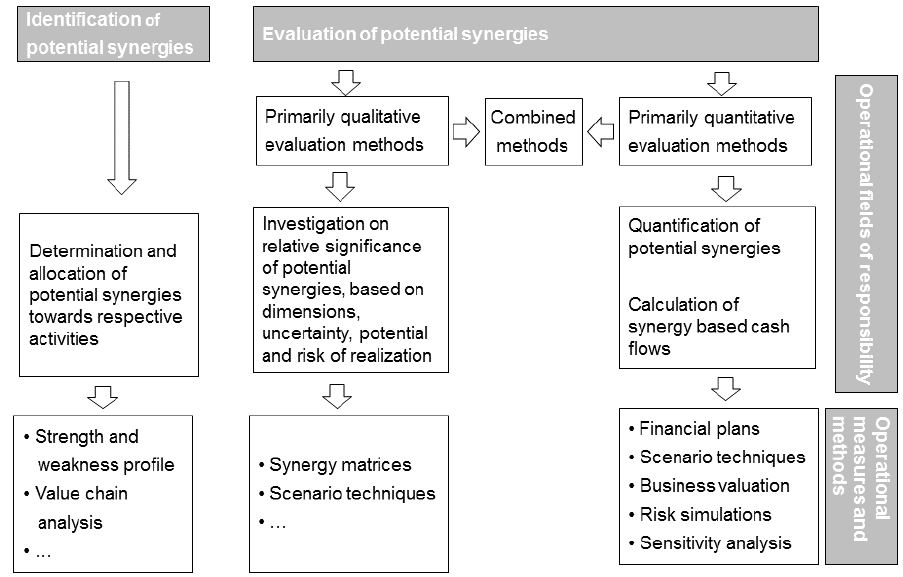
Figure 6. Overview of the duties and operational responsibility, measures, and methods during synergy-oriented acquisition management (pre-acquisition). Own illustration, based on Rockholtz et al. [17] (p.